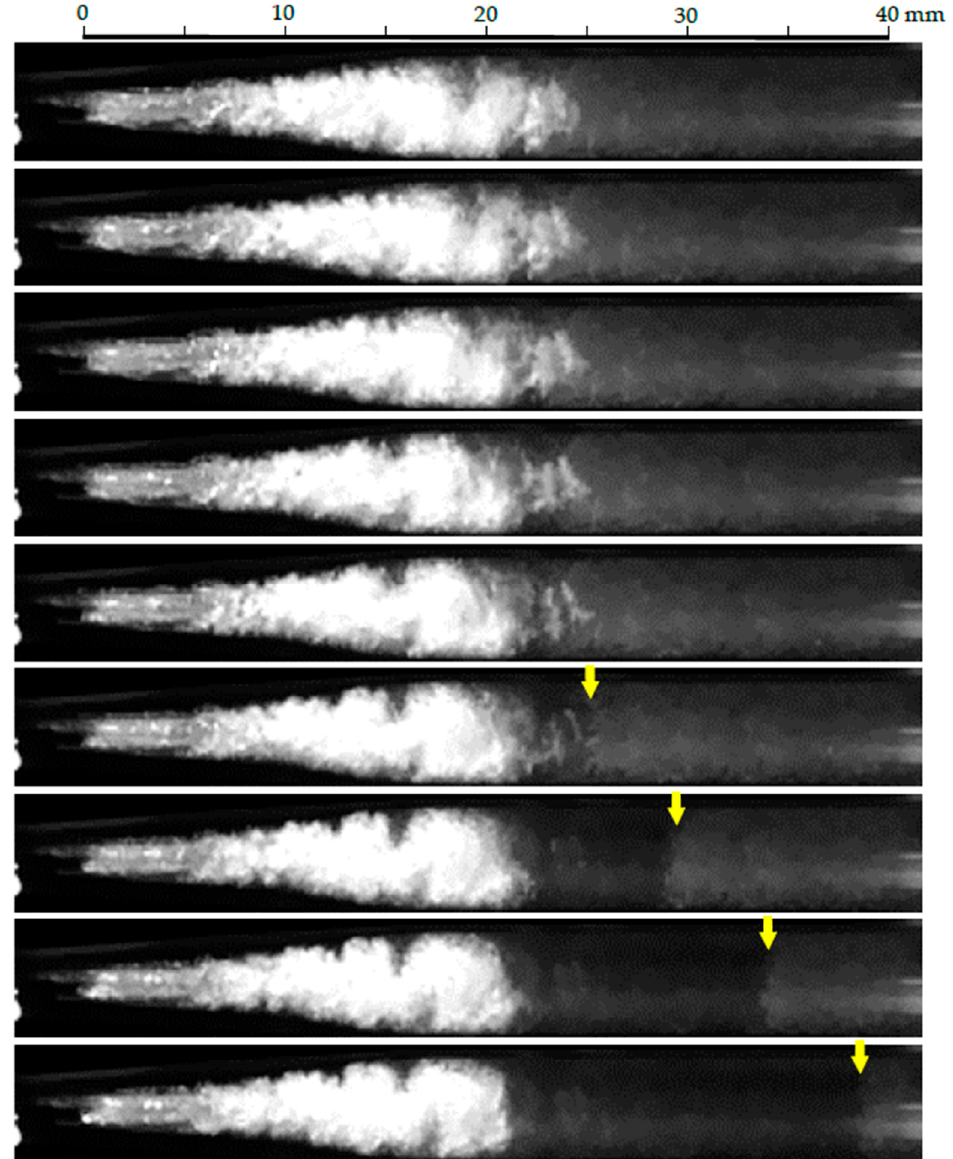
Figure 17. Aspects of vortex cavitation in Venturi tube observed by a high-speed video camera. The recording speed of the camera was 51,999 fps. A pressure wave, which is indicated by a yellow, arrow was observed after the vortex cavitation collapsed.